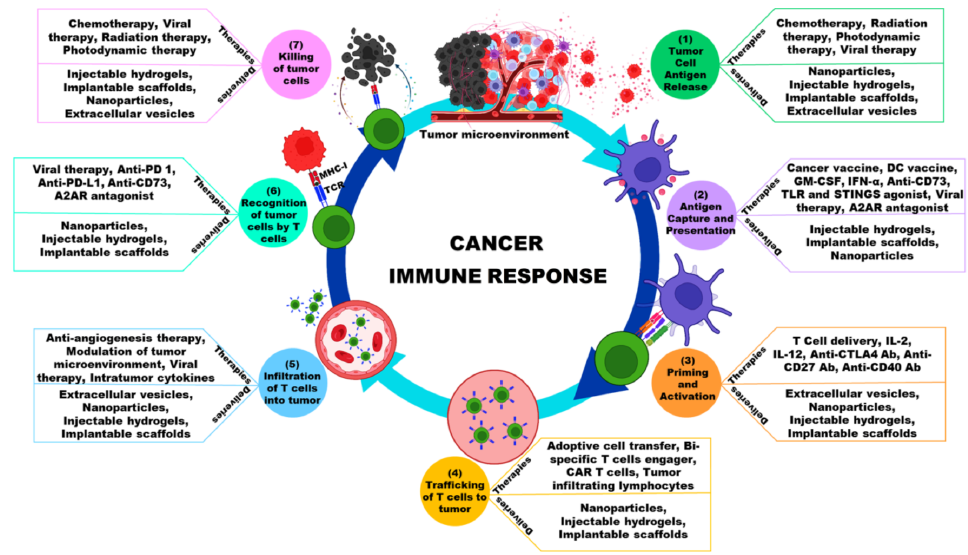
Figure 1. Schematic illustration showing the cancer immune response, interventional therapies and its delivery